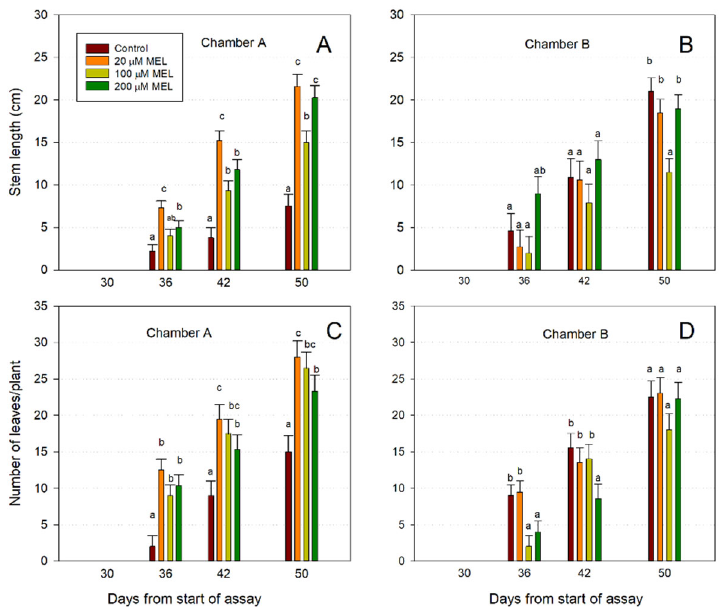
Figure 5. Effect of melatonin on stem length ( A , B ) and number of leaves/plant ( C , D ) of primed almond seeds after 30 days in chambers A and B, and subsequent growth in chamber E. Each bar represents the mean value ( n = 6) ±SE obtained for each concentration used of three repeated experiments. Superscript letters indicate significant differences with the control by each treatment based on a Duncan test with a significance level of p < 0.05.